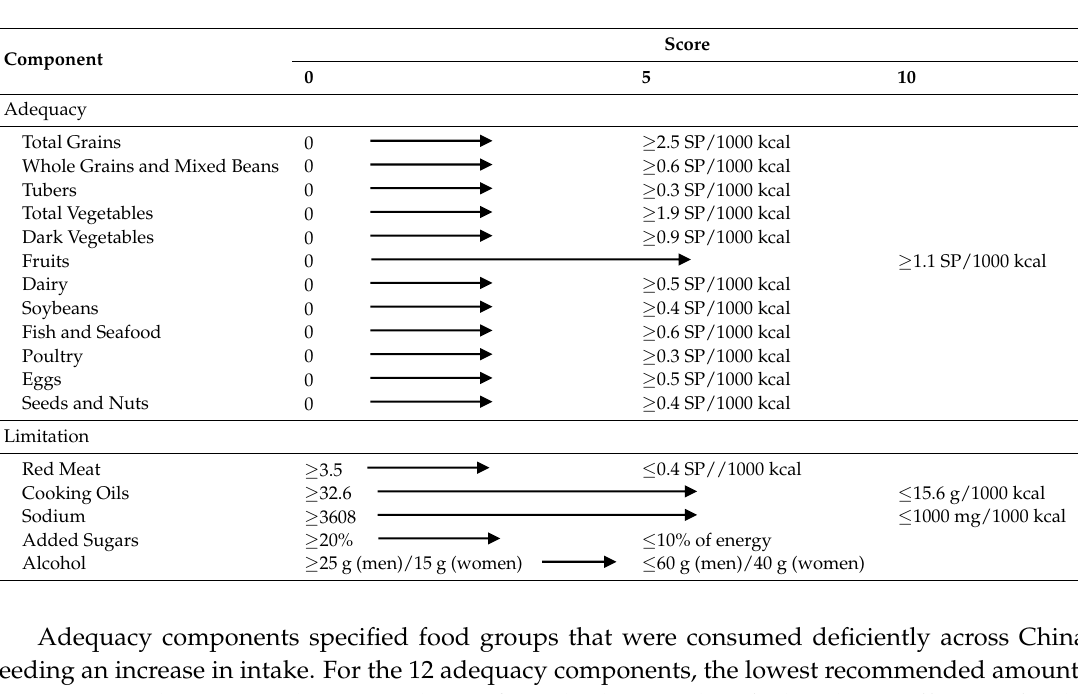
Table 3. Chinese Healthy Eating Index (CHEI) components and standard for scoring.